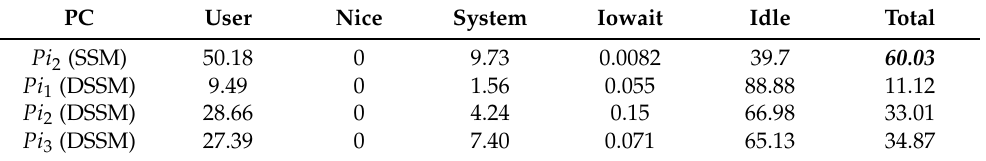
Table 9. Details of CPU usage in Ex 2.